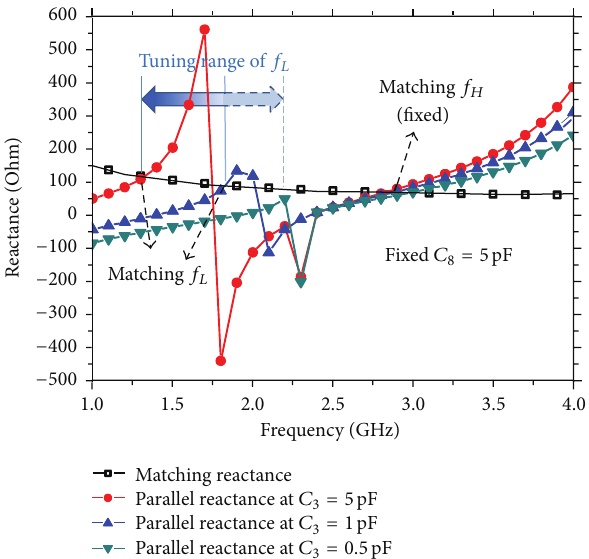
Figure 5: Dual-band frequency matching reactance in the cross- type network with different 𝐶 3 .